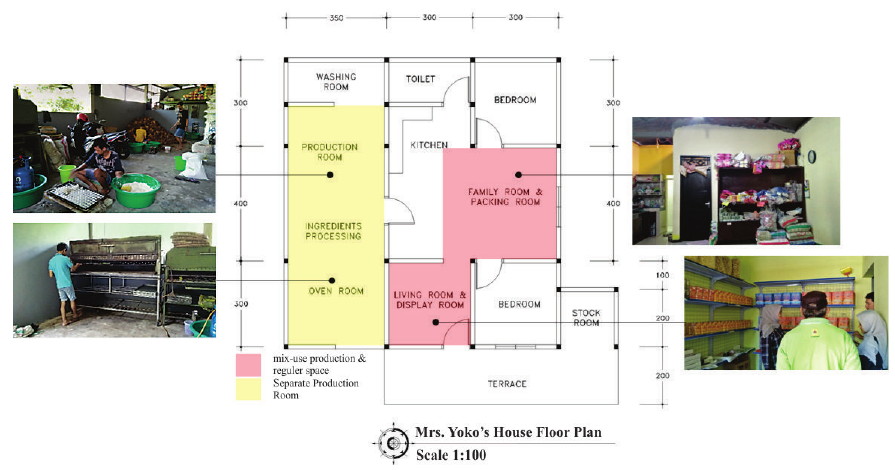
Figure 3. Mix-use production space & regular space in Mrs Yoko’s house (Case